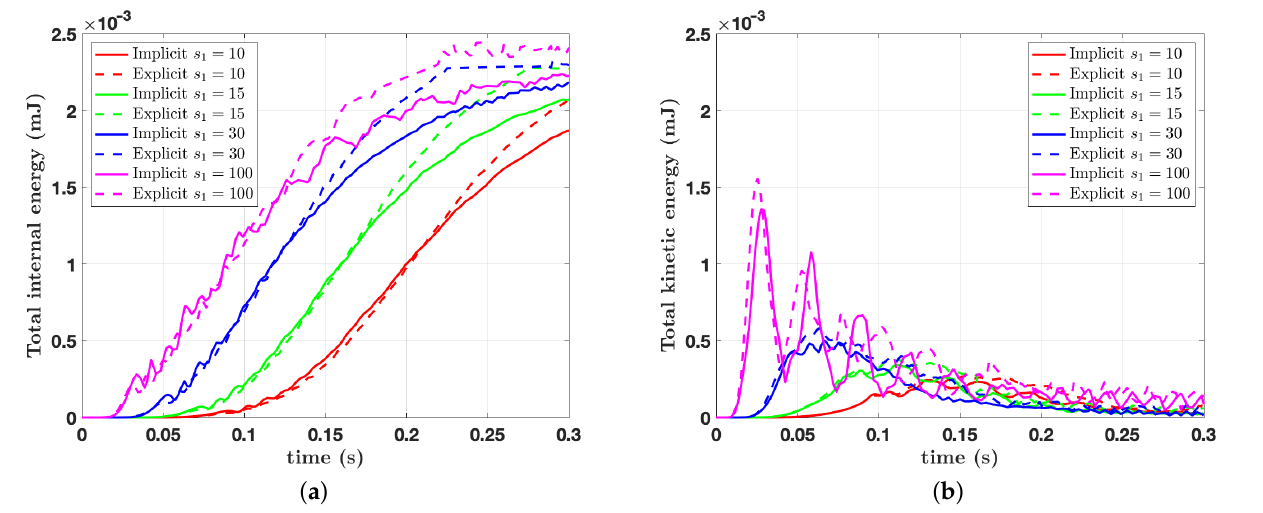
Figure 7. ( a ) Evolution of the total strain energy for all the activation signals considered using both algorithms; and ( b ) evolution of the total kinetic energy for all the activation signals considered using the implicit